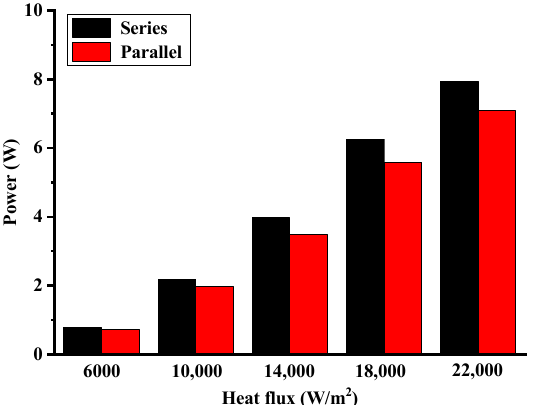
Figure 8. Comparison of connection mode on power output with four thermoelectric modules.